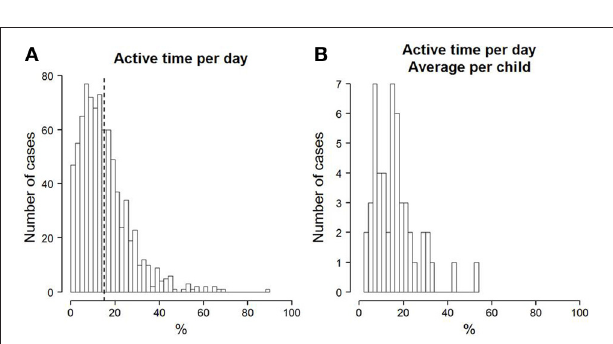
FIGURE 1 | (A) Histogram of the number of valid days per child. The dotted line depicts the mean across all children. (B) Histogram of the number of valid hours per day. Days with less than 6 valid hours were excluded from analyses. The dotted line depicts the mean across all days and children.